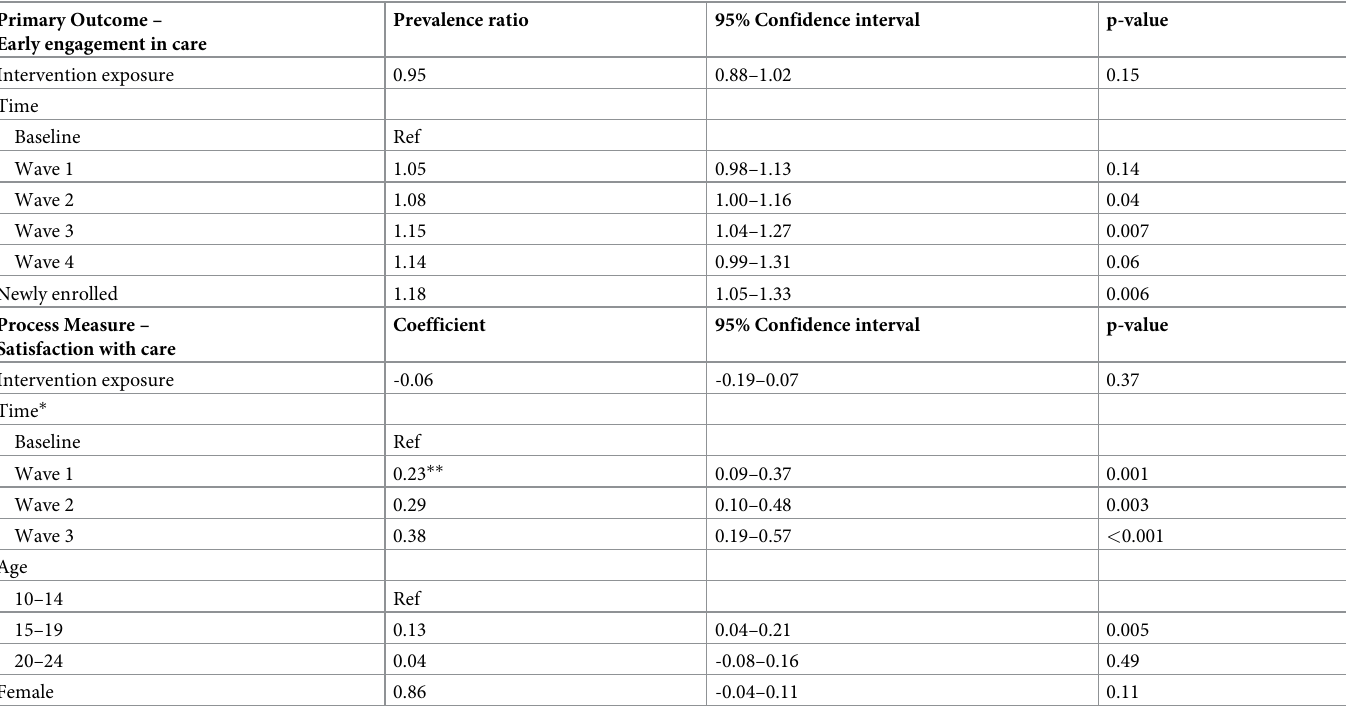
Table 5. Intervention exposure on early engagement (n = 4,595) and satisfaction with care (n =